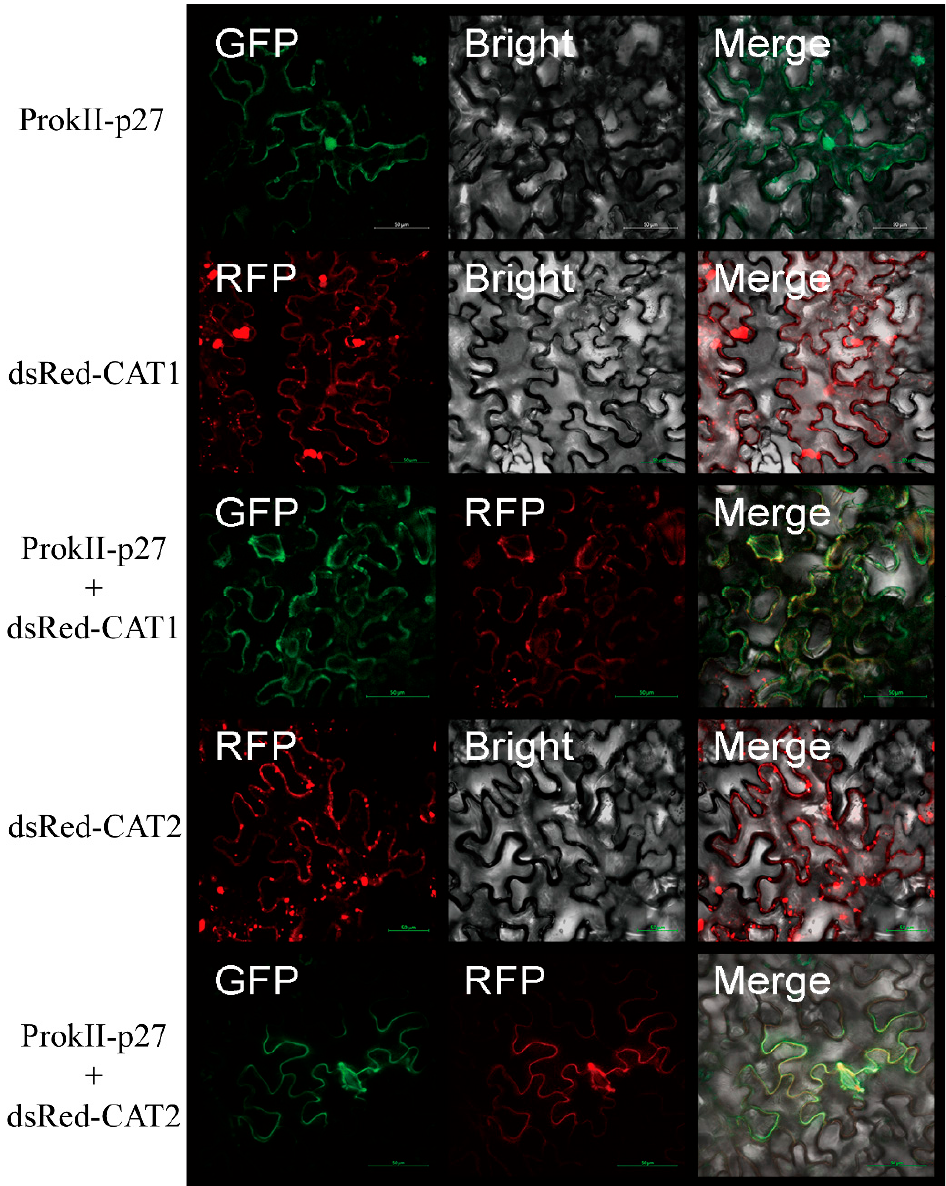
Figure 5. The expression of SlCAT1 and SlCAT2 changes the localisation of